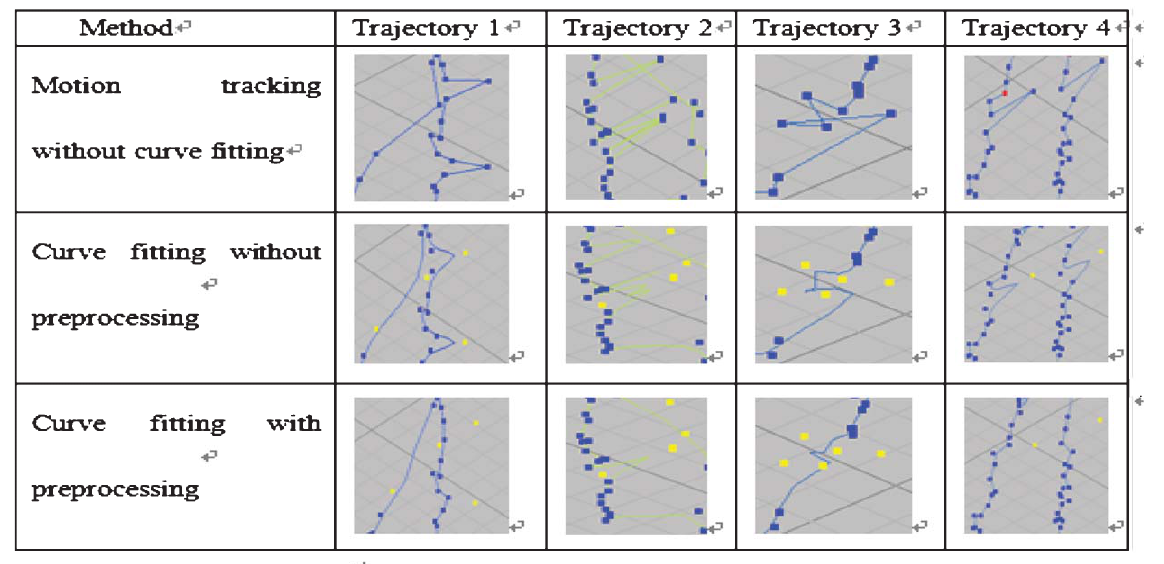
Fig. 7. Trajectories produced for four points using different methods.